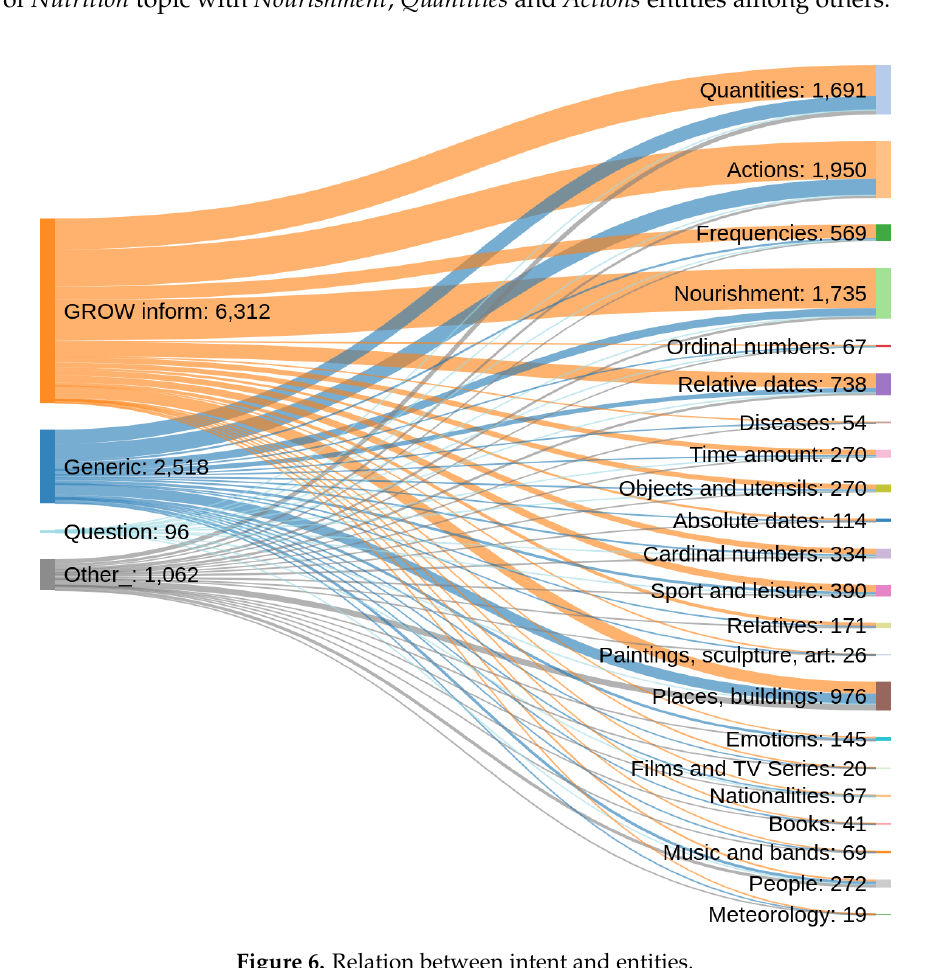
Figure 6. Relation between intent and